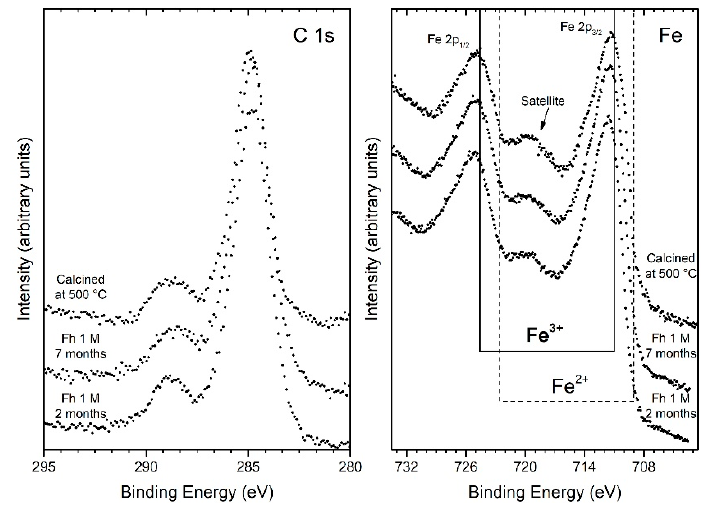
Figure 7. Core level C 1s and Fe 2p XPS spectra of the samples of hematite aged two months at RT (H RT2 ), aged seven months at RT (H RT7 ), and calcined at 500 °C (H 500 ).